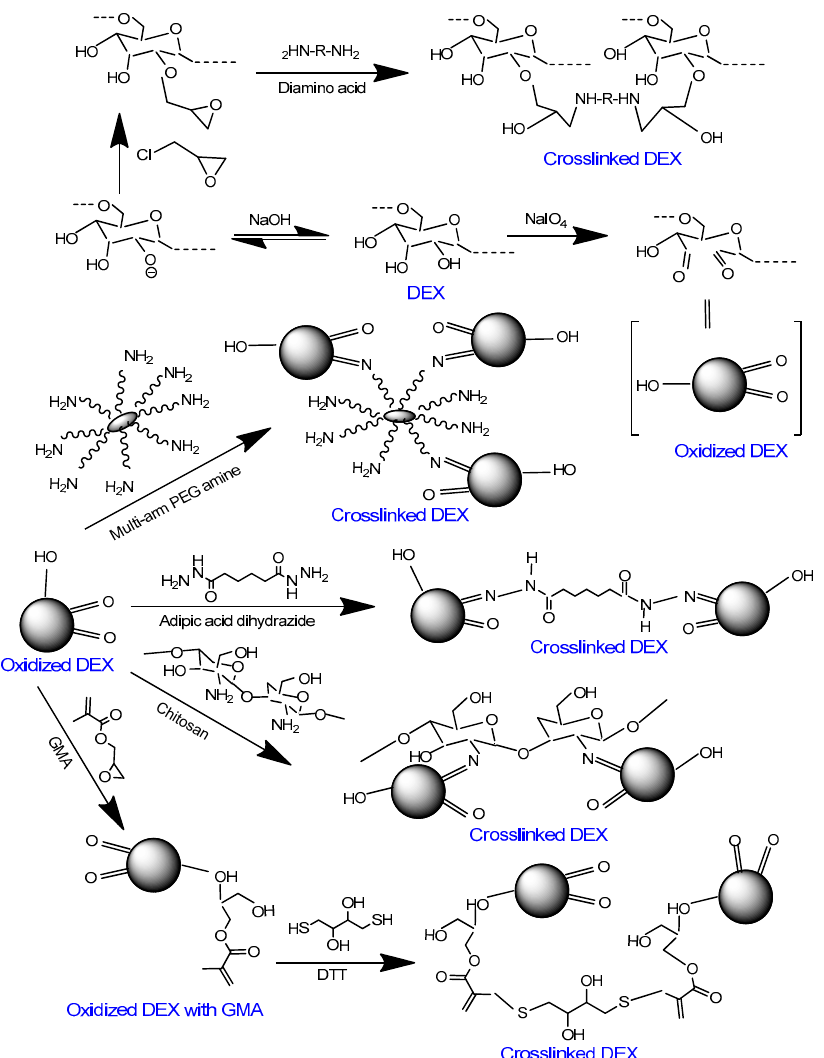
Figure 3. Scheme showing the crosslinking approaches for oxidized DEX. DEX can be oxidized via periodate treatment. Oxidized DEX can be crosslinked through the attachment mono-, bi-, and multi-armed amines [111,121–123]. Alternatively, glycidyl methacrylate (GMA) can be attached to oxidized DEX and the latter can be crosslinked with dithiothreitol (DTT) [120]. Some groups have investigated surface grafting and co-polymerization as a tool of improving the cell-adhesion of DEX [24,124,125]. Levesque et al. [125] developed scaffolds of methacrylated- DEX copolymerized with aminoethyl methacrylate. Herein, primary amine groups served as handles to covalently link RGD peptide. The adhesion and neurite outgrowth of primary embryonic chick dorsal root ganglia increased upon copolymerization. A further improvement was noticed upon peptide immobilization. Notably, direct coupling between peptide (amine) and hemiacetals of oxidized DEX destructed the conformation of peptides. At the same time, the presence of amine- pendants in the side-chain of constituent amino acids impaired the scaffold-cell interactions [124]. This has been minimized through the development of sulfhydryl-terminated peptides [125]. A recent study of Noel et al. [126] questioned the cell-selective response of ECM peptides using DEX scaffolds. Investigators illustrated the role of four ECM peptides (RGD, YIGSR, REDV, and CAG) upon adhesion and proliferation of HUVEC and AoSMC cells. A library of vinylsulfone-